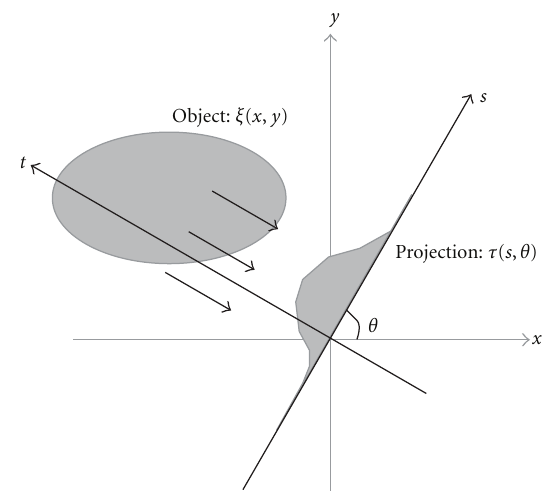
Figure 1: Schematic diagram of the Radon transform. Detectors are aligned on the s axis, which has an angle described as θ